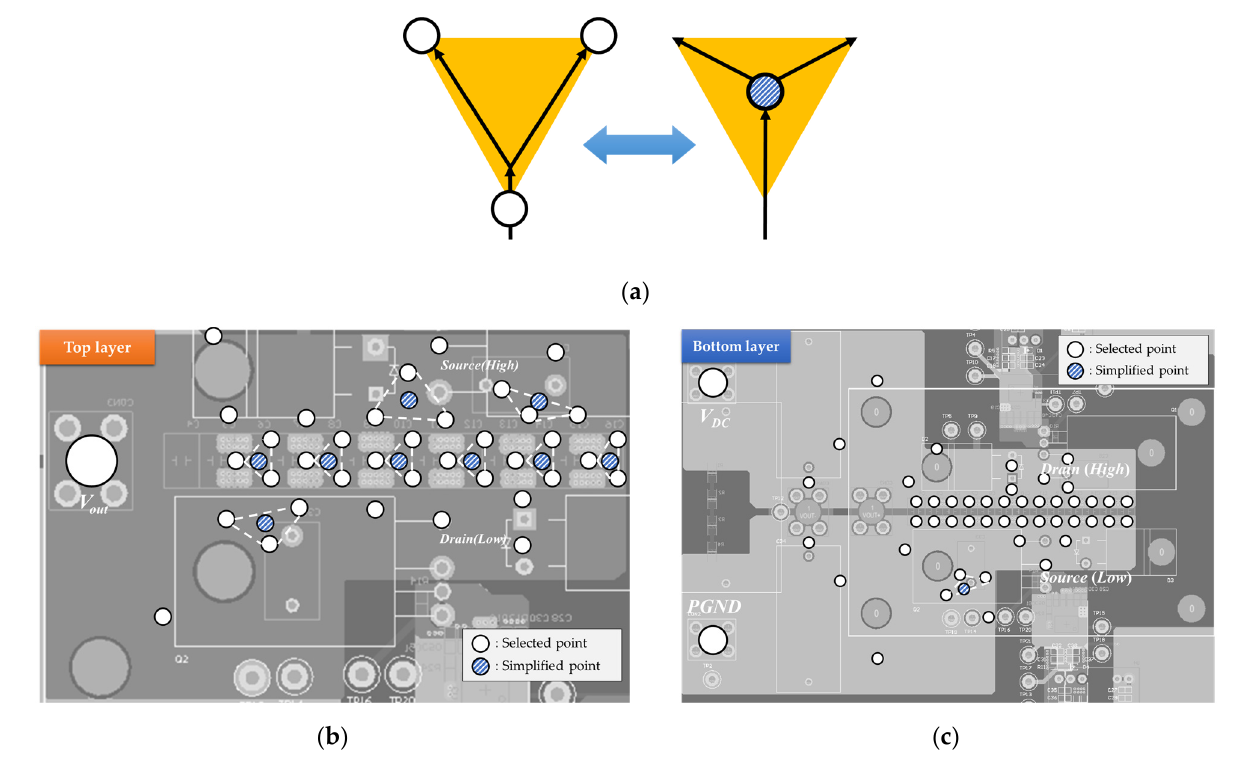
Figure 8. Simplification process of lumped parameter modeling. ( a ) Simplification method. ( b ) Simplified point at top layer. ( c ) Simplified point at bottom layer.